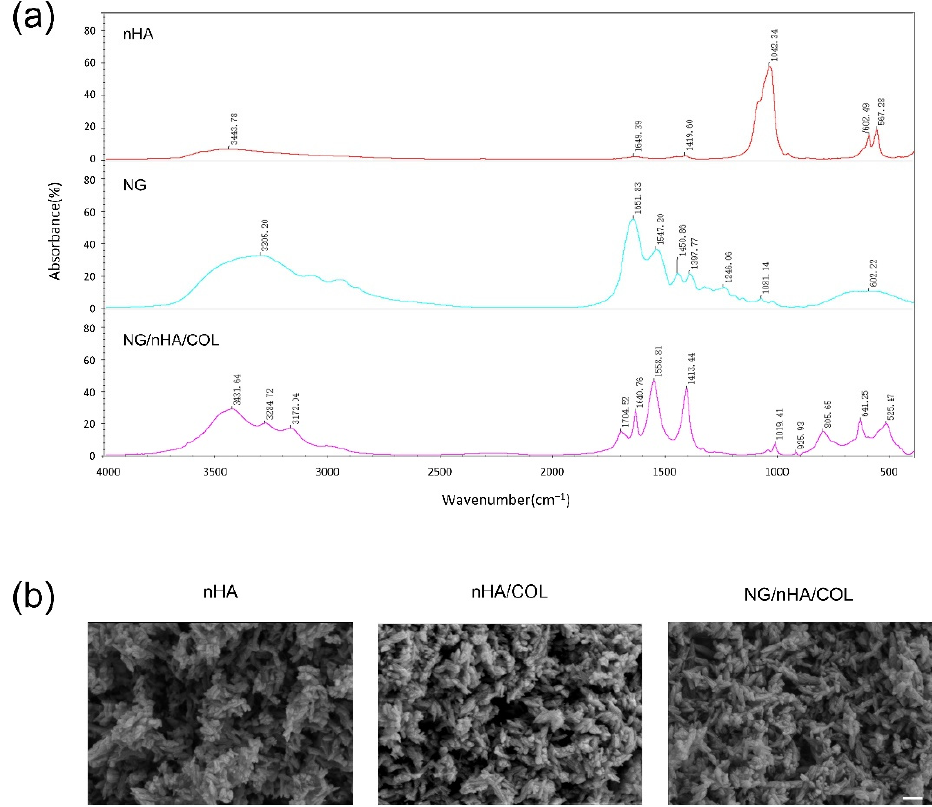
Figure 3. FTIR and SEM of scaffolds: ( a ) FTIR of nHA, NG, and NG/nHA/COL and ( b ) SEM of nHA, nHA/COL, and NG/nHA/COL; the mass ratio of nHA/COL is 7:3 (scale bar: 200 nm). SEM images revealed the porous spongy structure of nHA/COL scaffolds with differ- ent ratios. The porous spongy structure of the scaffolds did not change after introducing naringin into them (Figure 3b). (red) in all three study groups (control, nHA/COL, and NG/nHA/COL), and that live cells (green) were evenly distributed across the entire field of view (Figure 4a). Cell scaffold/nu ‐